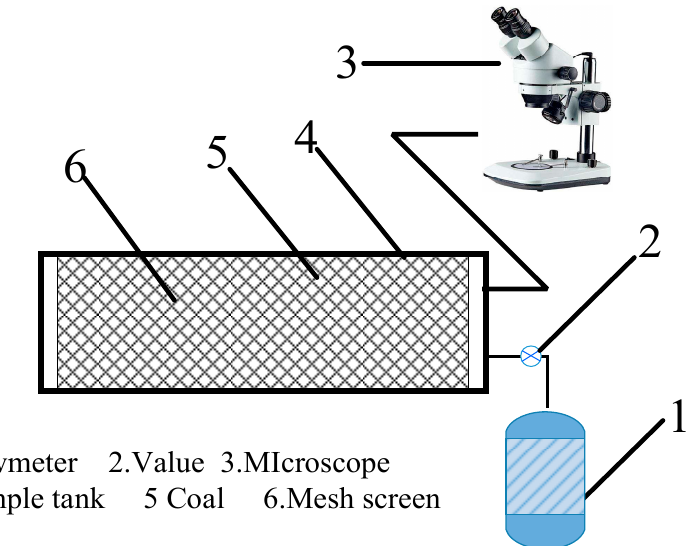
Figure 4. Schematic diagram of the